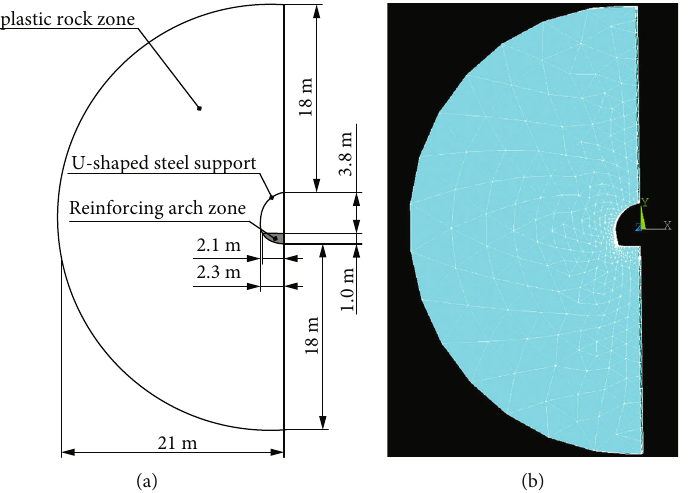
Figure 4: General view of model geometry (a) and fi nite element model in Ansys (b). Table 1: Input data for numerical